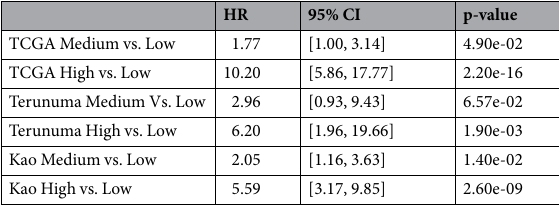
Table 1. Hazard Ratios for Overall Survival Model Risk